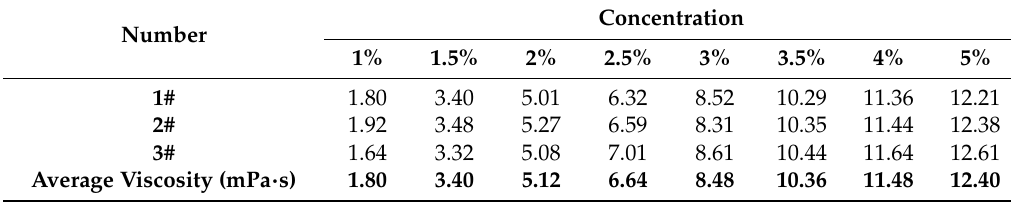
Table 5. Viscosities of SPI